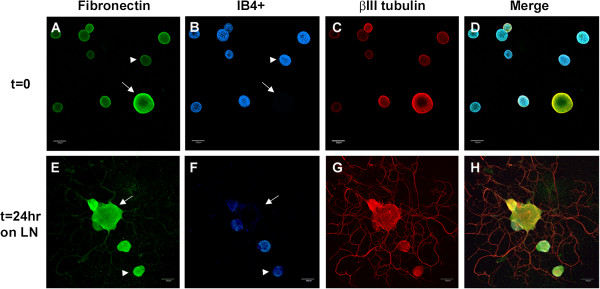
FN protein expression in DRG neurons. Dissociated DRG neurons were immunostained for fibronectin (green), neuron-specific βIII tubulin (red) and IB4 lectin labeling (blue) at t=0 (A-D) and t=24 hr after plating on LN (E-H). Both populations of cells express FN with no obvious difference detected by densitometry at t=0, although after 24 hr on LN, an increase in expression was observed for both populations. Scale bar-30 μm.